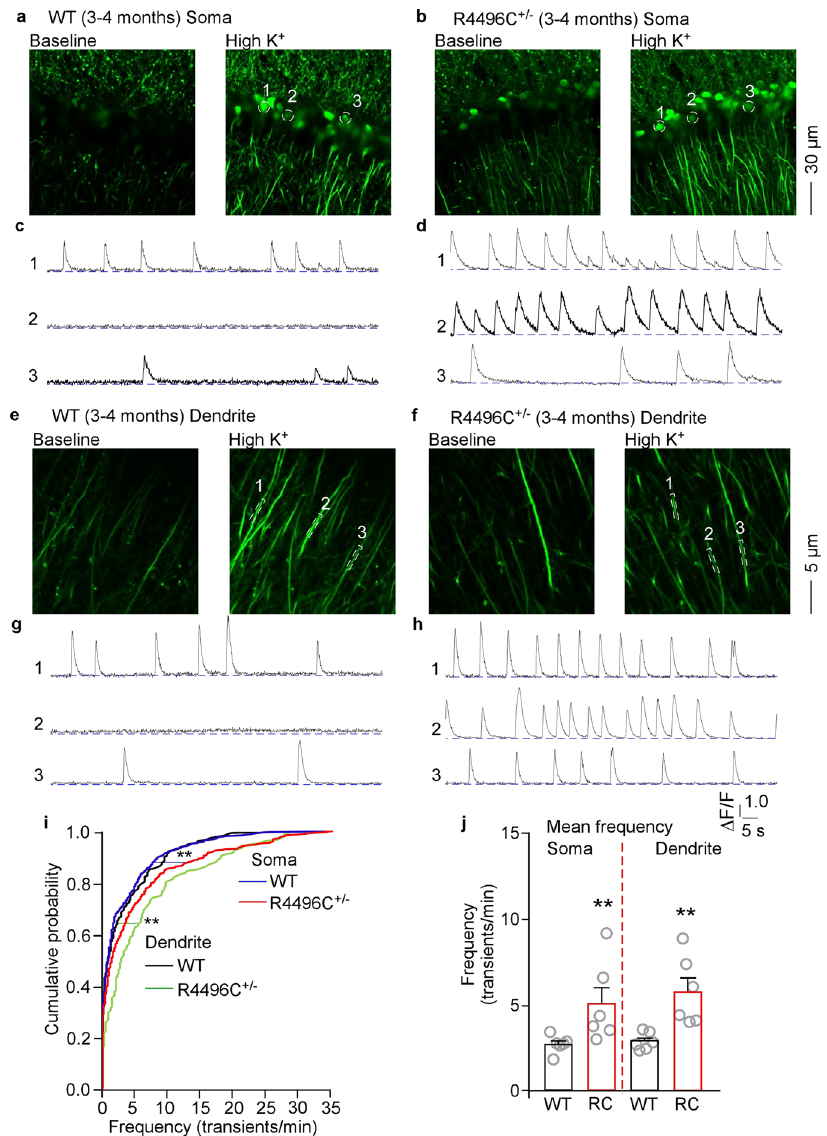
Fig. 5 CPVT RyR2 mutation R4496C + / − enhances spontaneous Ca 2 + transients in hippocampal CA1 neurons. Hippocampal brain slices were prepared from RyR2 WT/GCaMP6f + / − and RyR2-R4496C + / − /GCaMP6f + / − mice (3 – 4 months old) expressing the GCaMP6f Ca 2 + sensing probe. GCaMP6f fl uorescence signals from individual hippocampal CA1 neurons were continuously recorded at the resting condition (spontaneous Ca 2 + transients) for 5min, followed by the addition of KCl (50mM) (KCl-induced Ca 2 + transients) using the Leica SP8 DIVE up-right two-photon imaging system. Note that here KCl depolarization was applied to the brain slices after fi nishing recording of spontaneous Ca 2 + transients at rest to identify viable neurons. GCaMP6f fl uorescence images of hippocampal CA1 neurons in RyR2 WT/GCaMP6f + / − ( a ) and RyR2-R4496C + / − /GCaMP6f + / − ( b ) mouse brain slices at rest (baseline) and after KCl perfusion. c , d GCaMP6f fl uorescence traces of the three neurons circled in a and b at rest/baseline (i.e., without KCl perfusion), respectively. GCaMP fl uorescence images of hippocampal CA1 neuronal distal dendrites in RyR2 WT/GCaMP6f + / − ( e ) and RyR2-R4496C + / − /GCaMP6f + / − ( f ) mouse brain slices at rest and after KCl perfusion. g , h GCaMP6f fl uorescence traces of the three dendrites circled in e , f , respectively, at rest/baseline (i.e., without KCl perfusion). i Cumulative probability functions showing frequency distributions of spontaneous Ca 2 + transients at rest in the soma (blue) and dendrite (black) of CA1 neurons of 3 – 4 months old RyR2 WT/GCaMP6f + / − mice and in the soma (red) and dendrite (green) of CA1 neurons of 3 – 4 months old RyR2-R4496C + / − / GCaMP6f + / − mice (Kruskal – Wallis test with Dunn ’ s multiple comparisons test). j Mean frequency of spontaneous Ca 2 + transients at rest in the soma and dendrite area of CA1 neurons of 3 – 4 months old RyR2 WT/GCaMP6f + / − and RyR2-R4496C + / − /GCaMP6f + / − mice. Data shown are mean±SEM ( n = 18 slices from 6 RyR2 WT/GCaMP6f + / − brains with 600 somas, 182 dendrites, and n = 18 slices from 6 RyR2-R4496C + / − brains with 469 somas and 159 dendrites) (Mann – Whitney U test, ** p